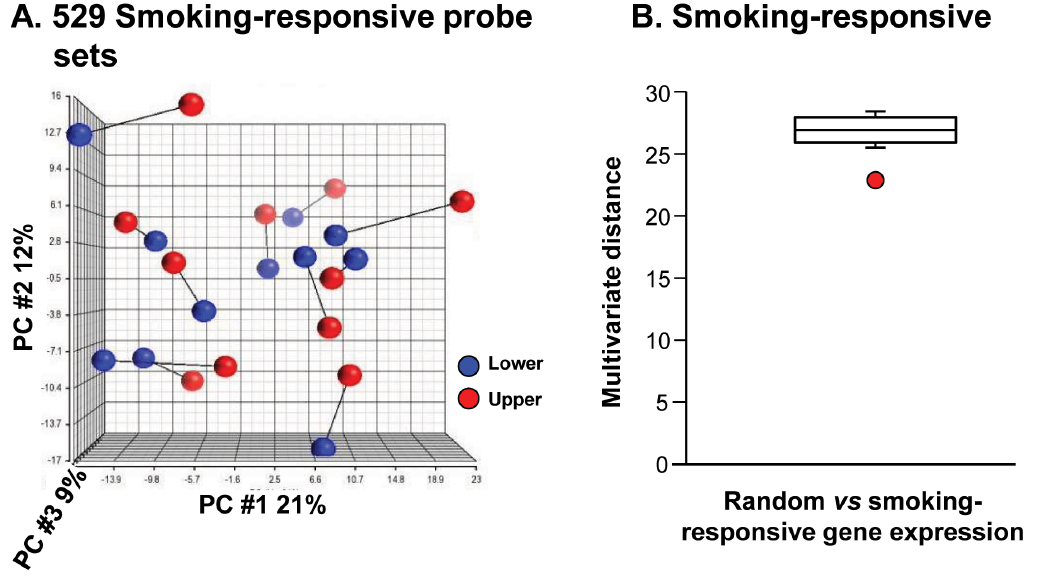
Figure 4. Principal component and multivariate vector length analysis of upper vs lower lobe gene expression of known smoking- responsive genes [ 25 ] . A. Principal component analysis (PCA) of the 529 probe sets of the smoking responsive list. Red=upper lobe samples; blue=lower lobe samples. The line connecting the red and blue data points connects the upper and lower lobe samples from the same individual. B. Plot of the distribution of the median distance between the upper and lower lobe samples for each individual in the space of 529 probe sets in the smoking- responsive list as measured by vector length (red circle) compared to the distribution of median distances between upper and lower lobe samples for 100 sets of 529 probe sets selected at random from the genome-wide list of probe sets present in at least 20% of the samples, minus the 529 smoking-responsive list (boxplot: middle bar is overall median, box contains the inner quartiles, and the whiskers, the 0.95 quartiles).